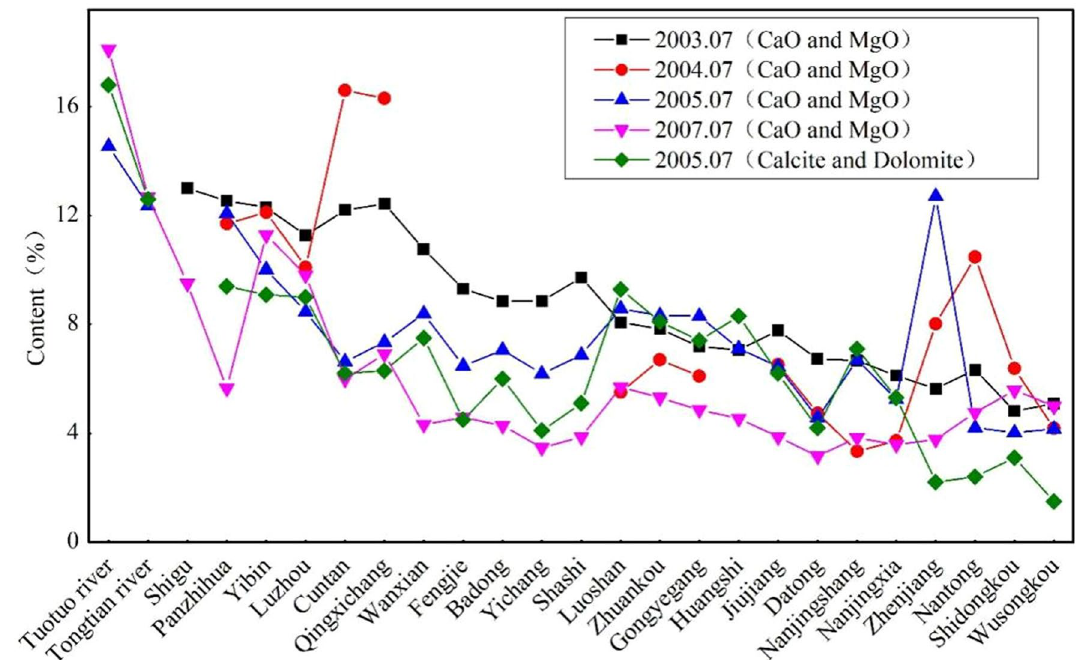
Figure 2. The variations of CaO, MgO, calcite and dolomite contents in suspended sediment along the mainstream of the Yangtze River.